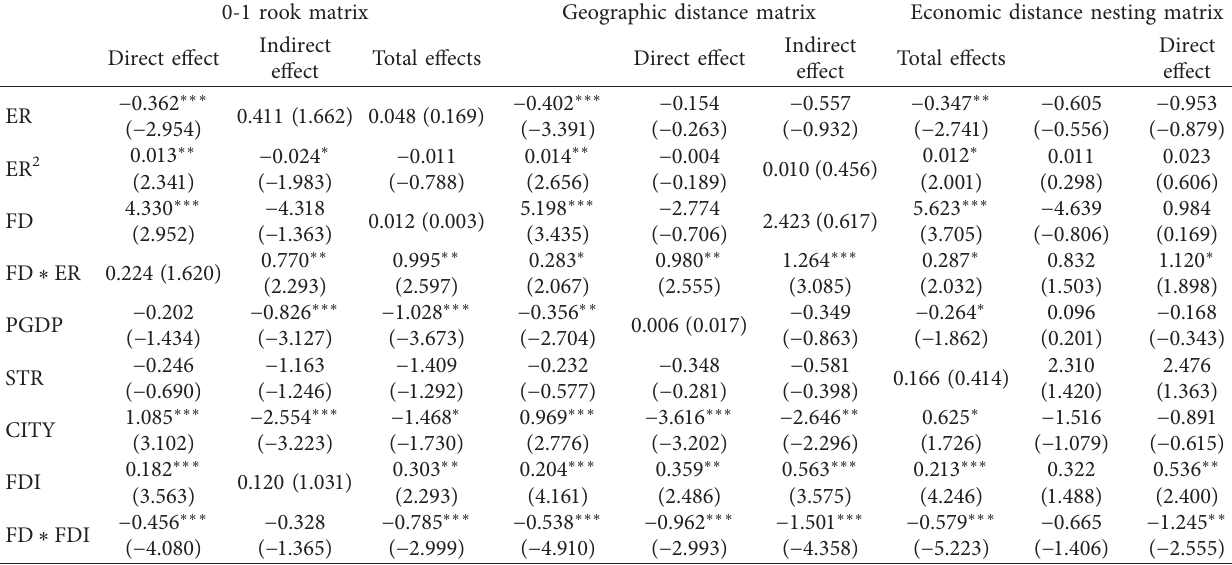
Table 7: The direct effects, indirect effects, and total effects of the spatial Durbin model (revenue fiscal